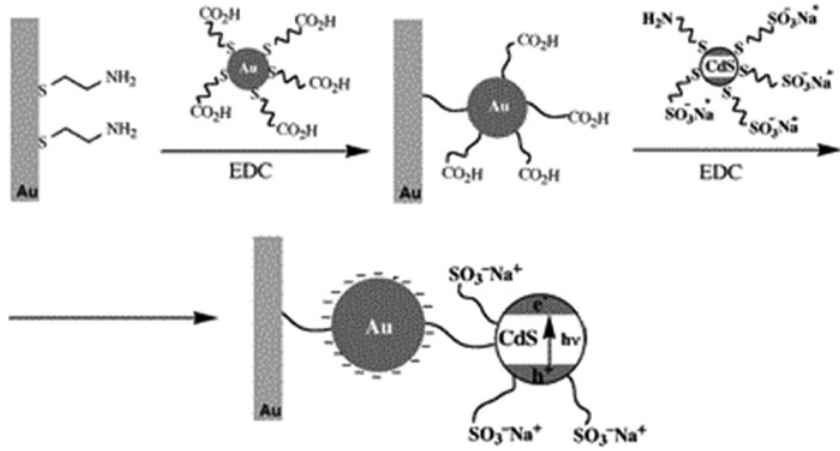
Figure 9: Illustration of the process of coupling AuNPs and CdS QDs on a substrate. In this case, AuNPs are first EDC coupled to a gold electrode. EDC coupling is then used again to couple the CdS QDS to the AuNPs. Adapted with permission from Ref. [94]. Copyright 2003 American Chemical